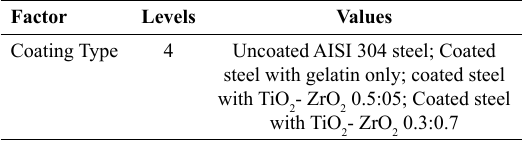
Table 3. Coating type factor levels.